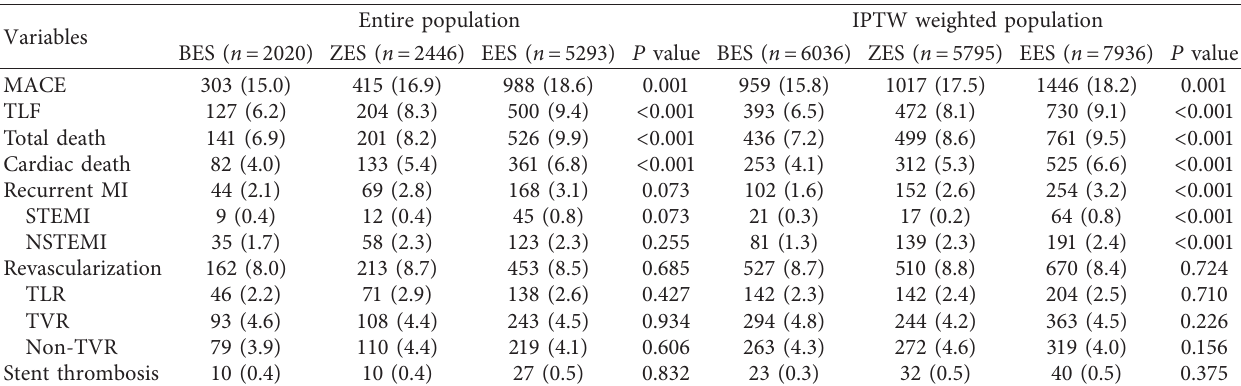
Table 2: Clinical outcomes of acute myocardial infarction patients with preserved left ventricular systolic function according to the use of DES type during a 3-year